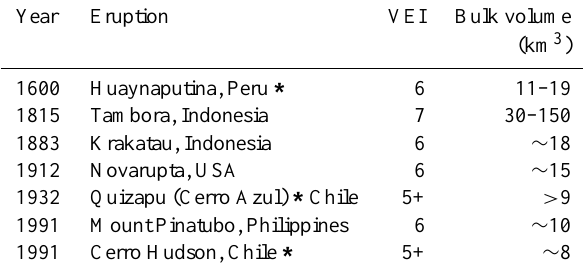
Table 3. The 1600 Huaynaputina eruption compared with the largest explosive eruptions of the 19th and 20th centuries world- wide. VEI=Volcanic Explosivity Index; ∗ Andean eruption. Note the wide range of estimated bulk volumes for the Huaynaputina and Tambora eruptions. (Various data sources, including: Naranjo et al., 1993; Simkin and Siebert, 1994; De Silva and Zielinksi, 1998; Hildreth and Drake, 1992; Thouret et al., 2002; Mason et al.,